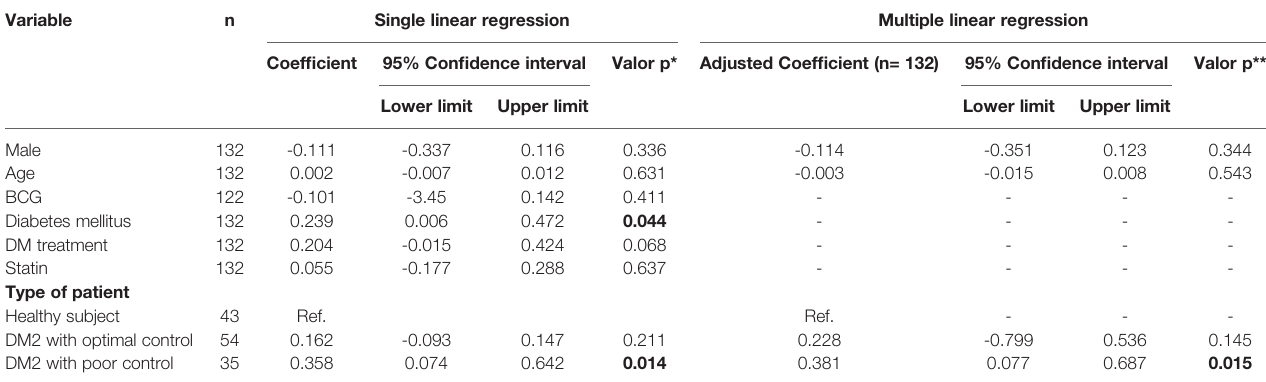
TABLE 1 | Association between inhibitory capacity against mycobacterial and DM2.